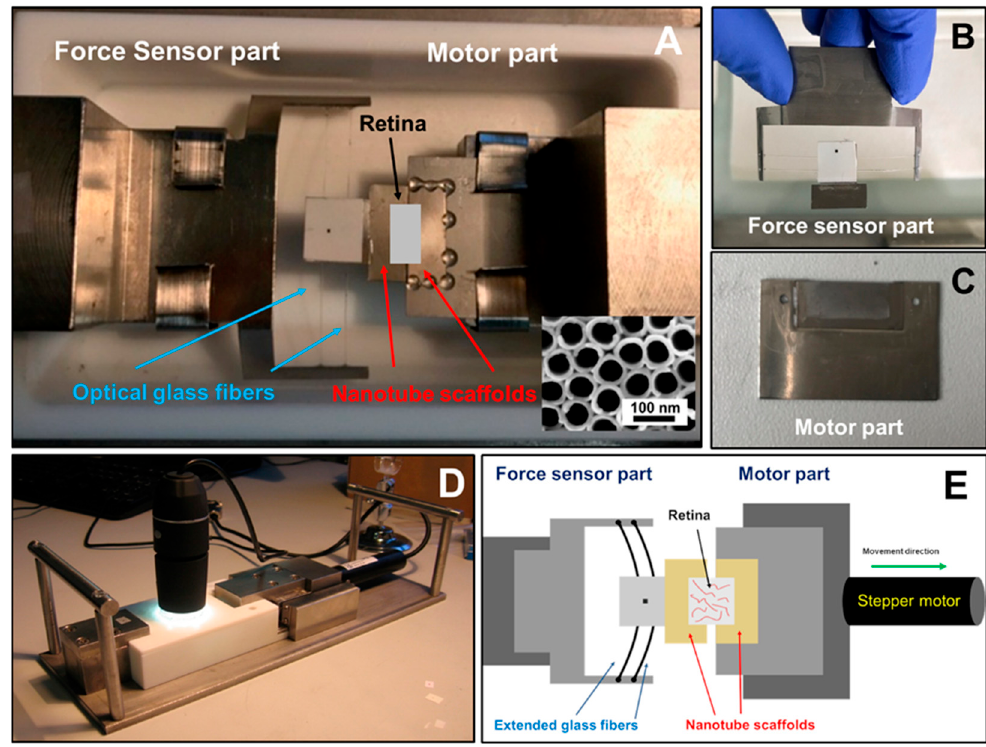
Figure 1. ( A ) Setup of our self-designed tissue stretcher: force sensor and motor parts of the tissue stretcher. The entire device is mounted within a Teflon mold in which culture medium is filled. The position of the retina is marked by the white rectangle. ( B ) For the force sensor part, a printed rectangular dot on the white sticker was glued on top of the stainless-steel plate in order to track the position during stretching and thus the elongation of the glass fibers. ( C ) The motor part